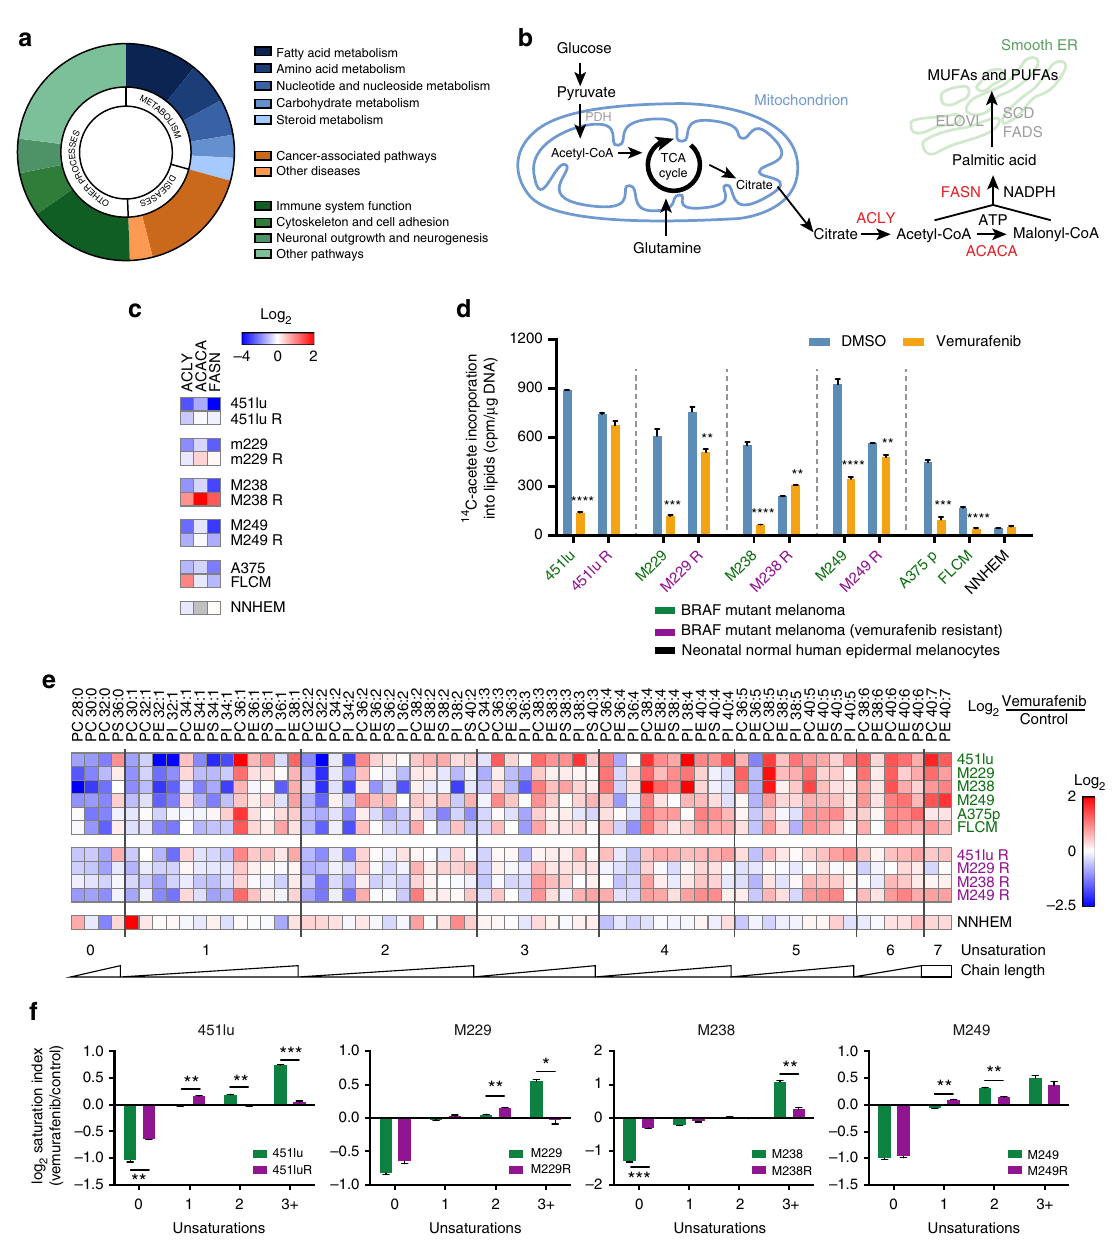
Fig. 1 De novo lipogenesis is inhibited by vemurafenib in therapy-sensitive cells, but remains activated in therapy-resistant ones. a Signi fi cantly altered (fold change of at least 1.5 and p < 0.05) pathways as indicated by ingenuity pathway analysis (IPA) of RNA-seq of vemurafenib (5 μ M) treated M249 and A375 cells ( n = 3). b Vemurafenib affects major components of the fatty acid synthesis pathway (fatty acid synthase, ATP citrate lyase and acetyl-CoA carboxylase). c The effects of vemurafenib treatment on the mRNA levels of FASN, ACLY, and ACACA in therapy-sensitive versus resistant BRAF-mutant cell lines and in NHEM ( n = 3). d Vemurafenib or vehicle treated cells were assayed for their ability to incorporate 14 C-acetate into lipids. Data are represented as mean ± s.e.m. The signi fi cance was determined with an unpaired t -test and compares vemurafenib-treated cells to their matching controls ( n = 3). (* p < 0.05, ** p < 0.01, *** p < 0.001, **** p < 0.0001). e Heatmap of log 2 ratios of the abundance of phospholipid species in vemurafenib-treated cells over vehicle treated cells. Species are indicated by their total number of fatty acid carbons, followed by a colon and the total number of unsaturations ( n = 3). f log 2 ratios of the vemurafenib-induced changes in saturation index. The saturation index was calculated by summing the species with the same level of